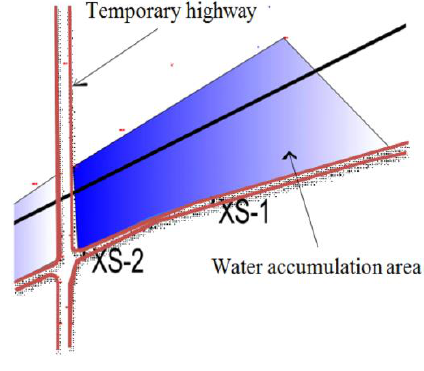
Figure 19. Location of measuring points. Table 1. Density test results.